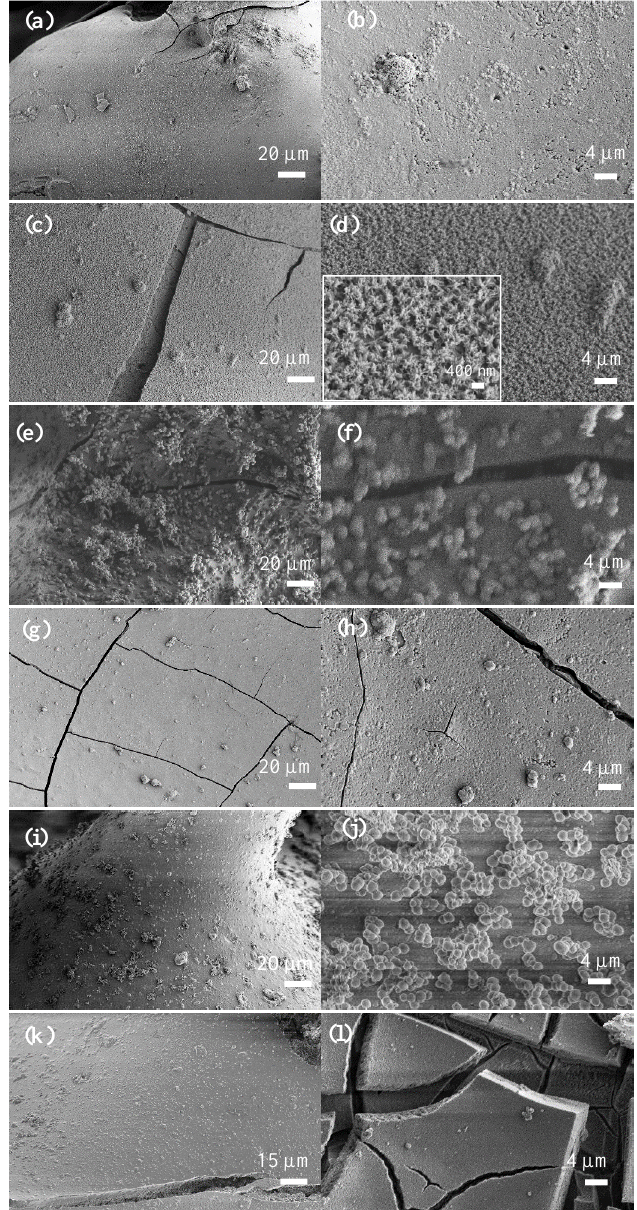
Figure 6. SEM micrographs of the SBF-treated bioactive glass scaffolds for 7 d ( a , b ) B3; ( c , d ) 0.1 hBN-B3; ( e , f ) 0.2 hBN-B3; ( g , h ) 0.5 hBN-B3; ( i,j ) 1 hBN-B3; ( k,l ) 2 hBN-B3.